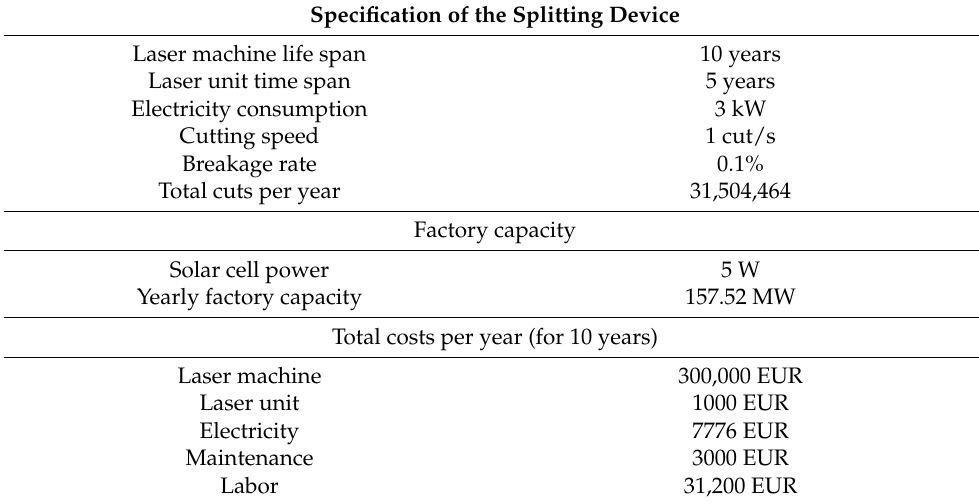
Table 2. Specifications of the splitting device, factory capacity and operating costs within the lifetime of the device for a company using M2